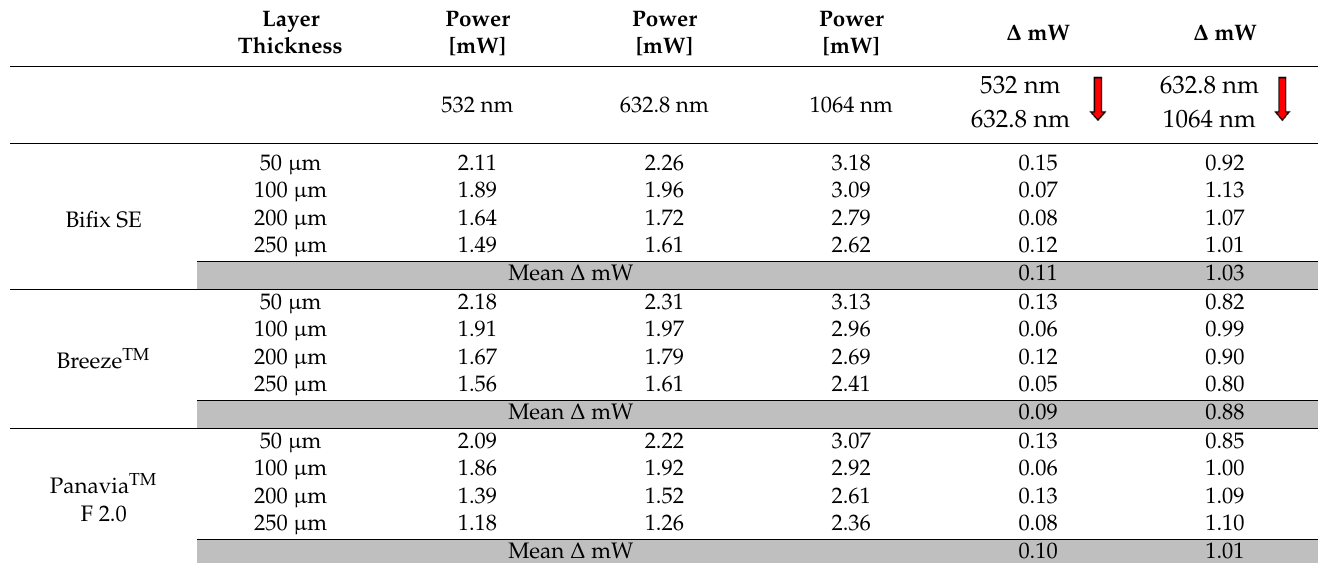
Table 1. Transmitted power values as a function of material, layer thickness, and wavelength. ∆ mW specifies the difference in values of the transmitted powers among the corresponding wavelengths, thus giving information about their increase.